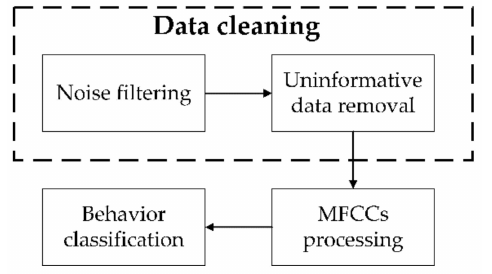
Figure 3. Overall workflow of the algorithms. MFCC is Mel-frequency cepstral